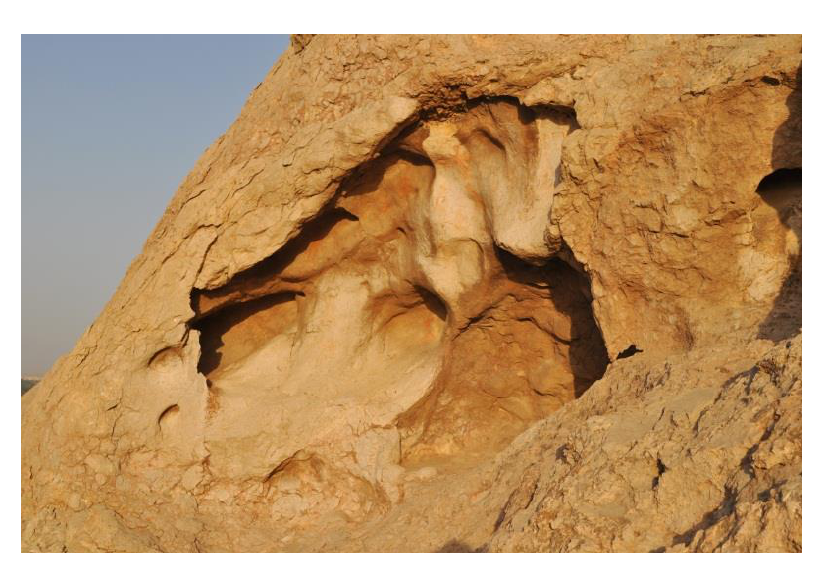
Figure 2. Kuh-e-Donbeh. View of Site